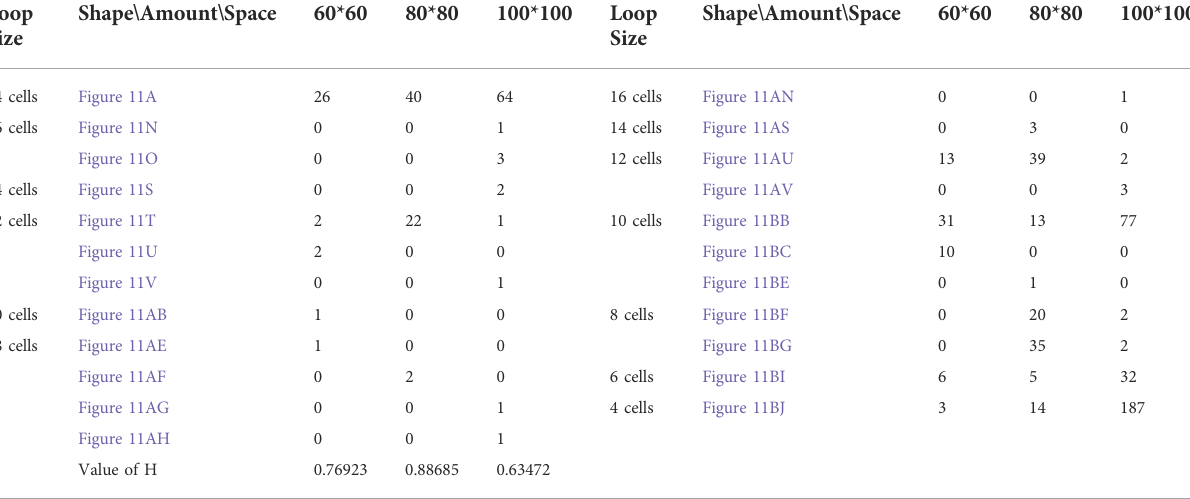
TABLE 13 Statistical numbers of the loops with various structures for the changing mechanism on different cellular spaces starting from the initial con fi guration in Figure 7D. Loop Size